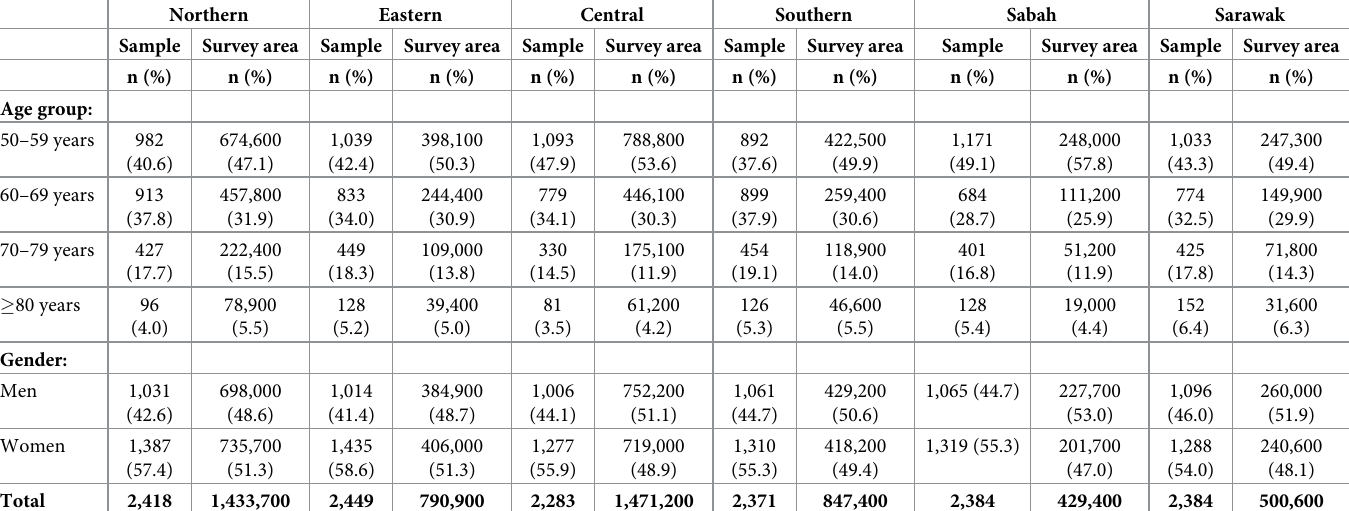
Table 1. Survey area population.